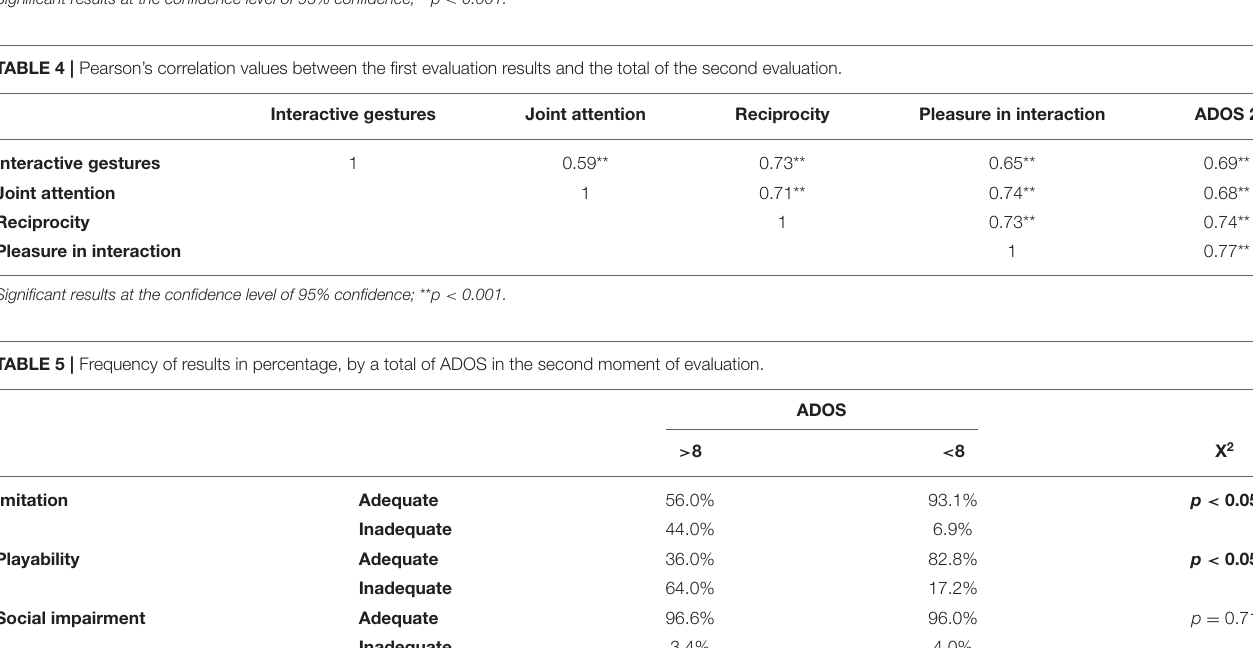
Significant results at the confidence level of 95% confidence; ** p < 0.001.